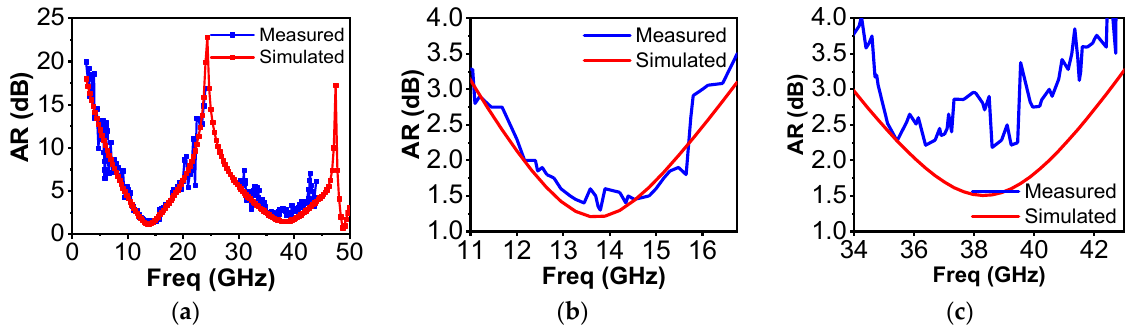
Figure 5. ( a ) Fabricated polarizer. ( b ) Ku band and ( c ) Ka band test setup for the polarizer.